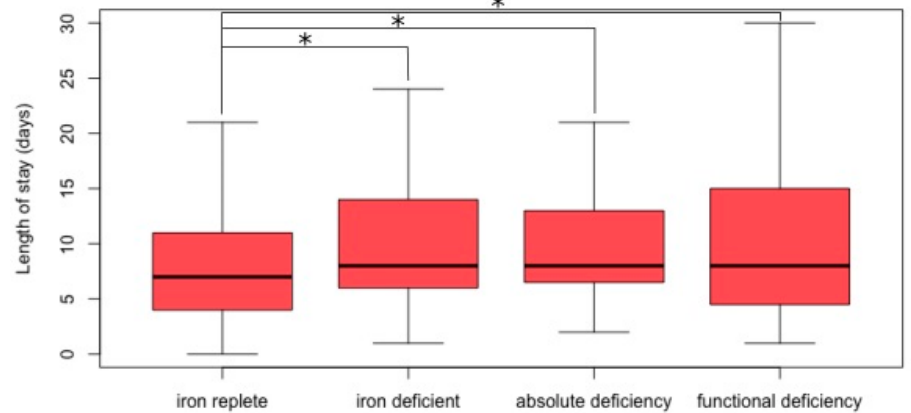
Figure 1. Length of stay according to iron status in heart failure with preserved ejection fraction (HFpEF). Iron replete patients have a significantly lower length of stay than iron deficient patients, across all groups. * denotes p -value less than the significance threshold of <0.05. Table 2. Patient characteristics, biomarker levels and diastolic function indices on TTE according to iron status in the HFpEF cohort.